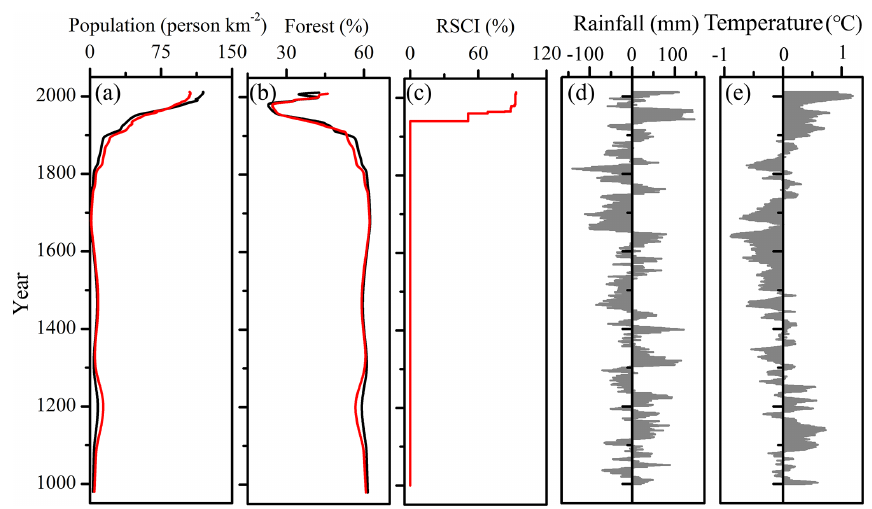
Figure 2. Model input data for the Yalu River for the period 1000–2012, including (a) population density (Sheng et al., 2019); (b) percentage forest coverage of the basin (Sheng et al., 2019); (c) total reservoir storage capacity index (RSCI: reservoir storage capacity/annual average water discharge); (d) annual average rainfall anomalies; and (e) annual average temperature anomalies (Liu et al., 2009,